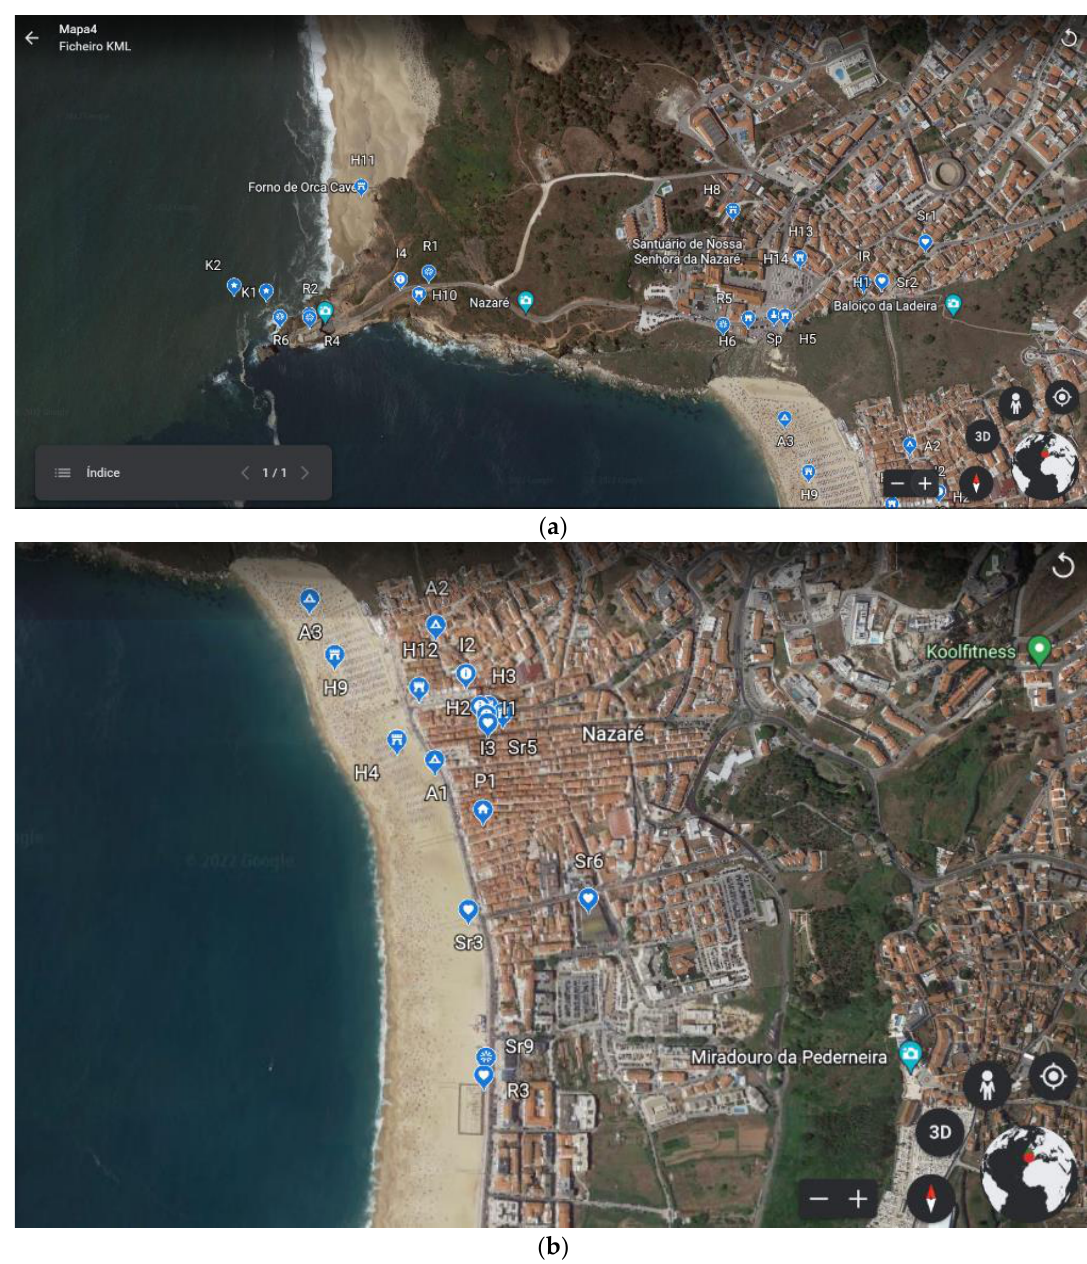
Figure 6. ( a ) Amplification of Google Earth map Zone A (around the Fortress); ( b ) amplification of Google Earth map Zone B (Nazaré town center).